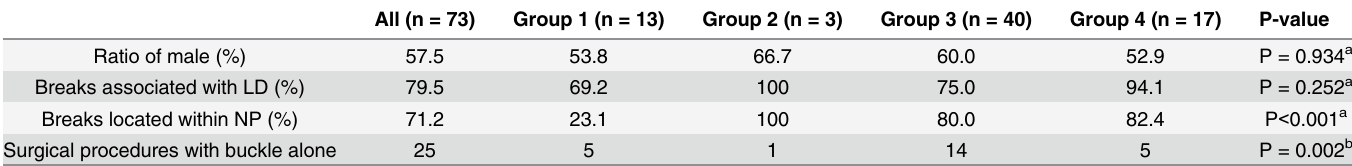
Table 1. Comparison of the ratio of gender, whether the retinal breaks associated with lattice degeneration, and located within the non-perfusion area among the 4 groups. All (n = 73) Group 1 (n = 13) Group 2 (n = 3) Group 3 (n = 40) Group 4 (n = 17) P-value Ratio of male (%) 57.5 53.8 66.7 60.0 52.9 P = 0.934 a Breaks associated with LD (%) 79.5 69.2 100 75.0 94.1 P = 0.252 a Breaks located within NP (%) 71.2 23.1 100 80.0 82.4 P < 0.001 a Surgical procedures with buckle alone 25 P = 0.002 b LD, lattice degeneration; NP, non-perfusion area; Y, yes; N: no.